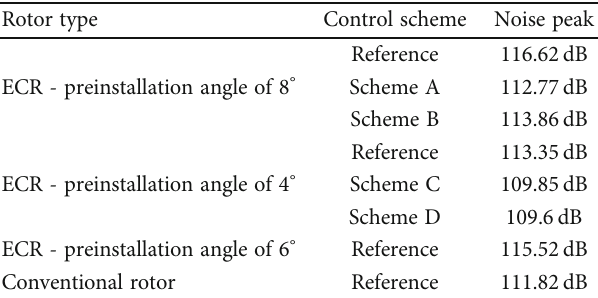
Figure 19: Wake vorticity cloud plot of the y = − 0 : 7 R longitudinal pro fi le on the advancing side of the sample ECR. Table 2: Comparison of the e ff ect of fl ap nonharmonic input on noise